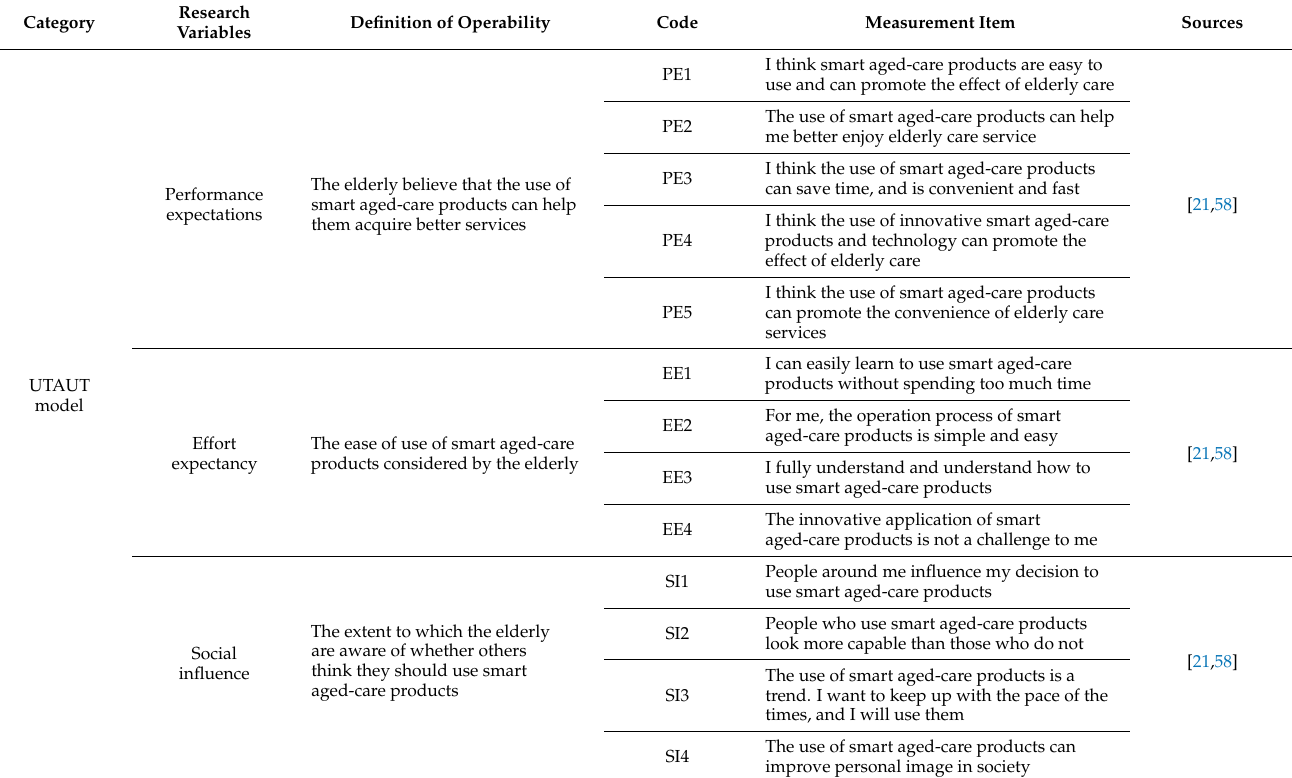
Table 1. Definitions of variable’s operability and the reference scales.